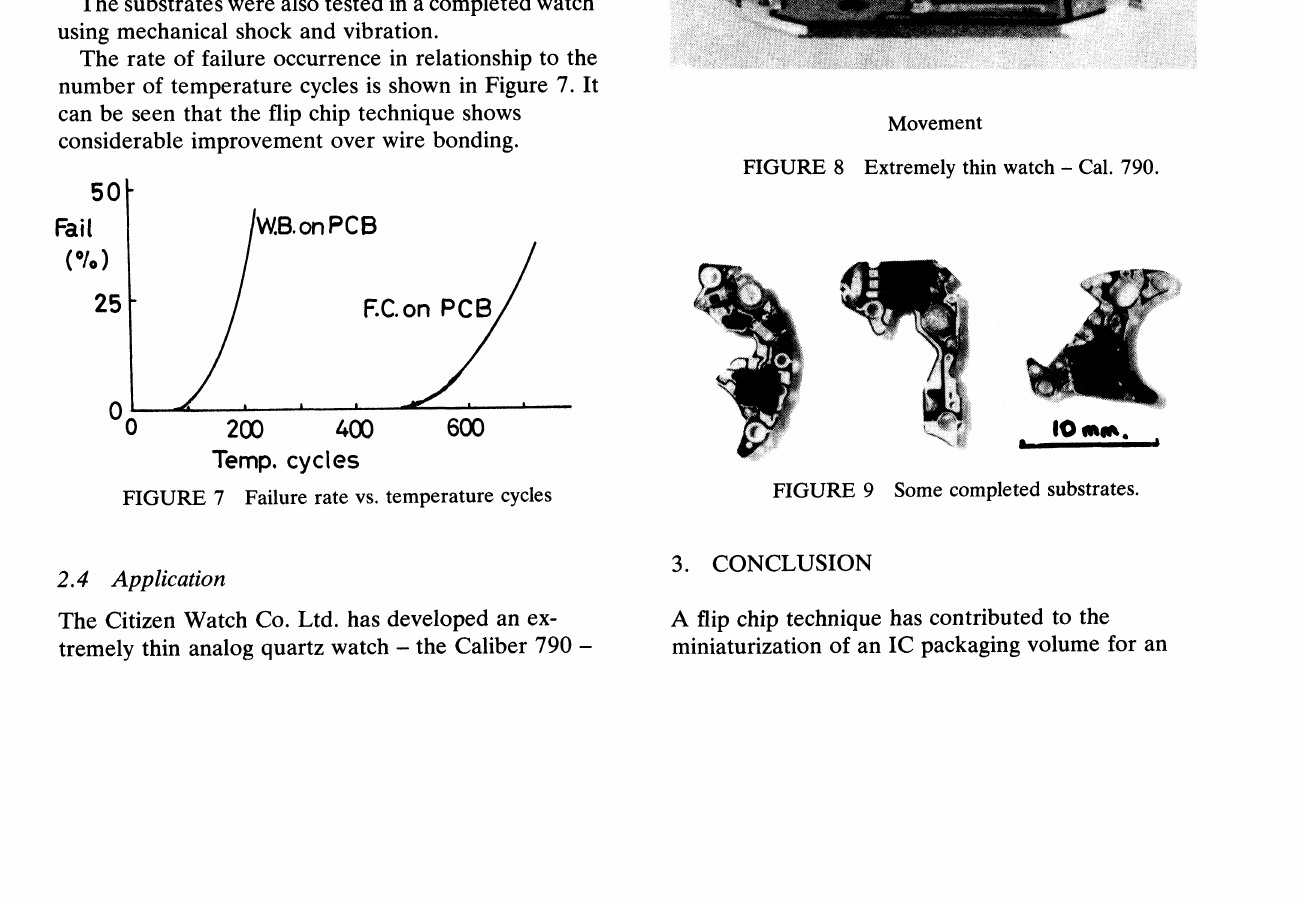
FIGURE 8 Extremely thin watch Cal. 790.